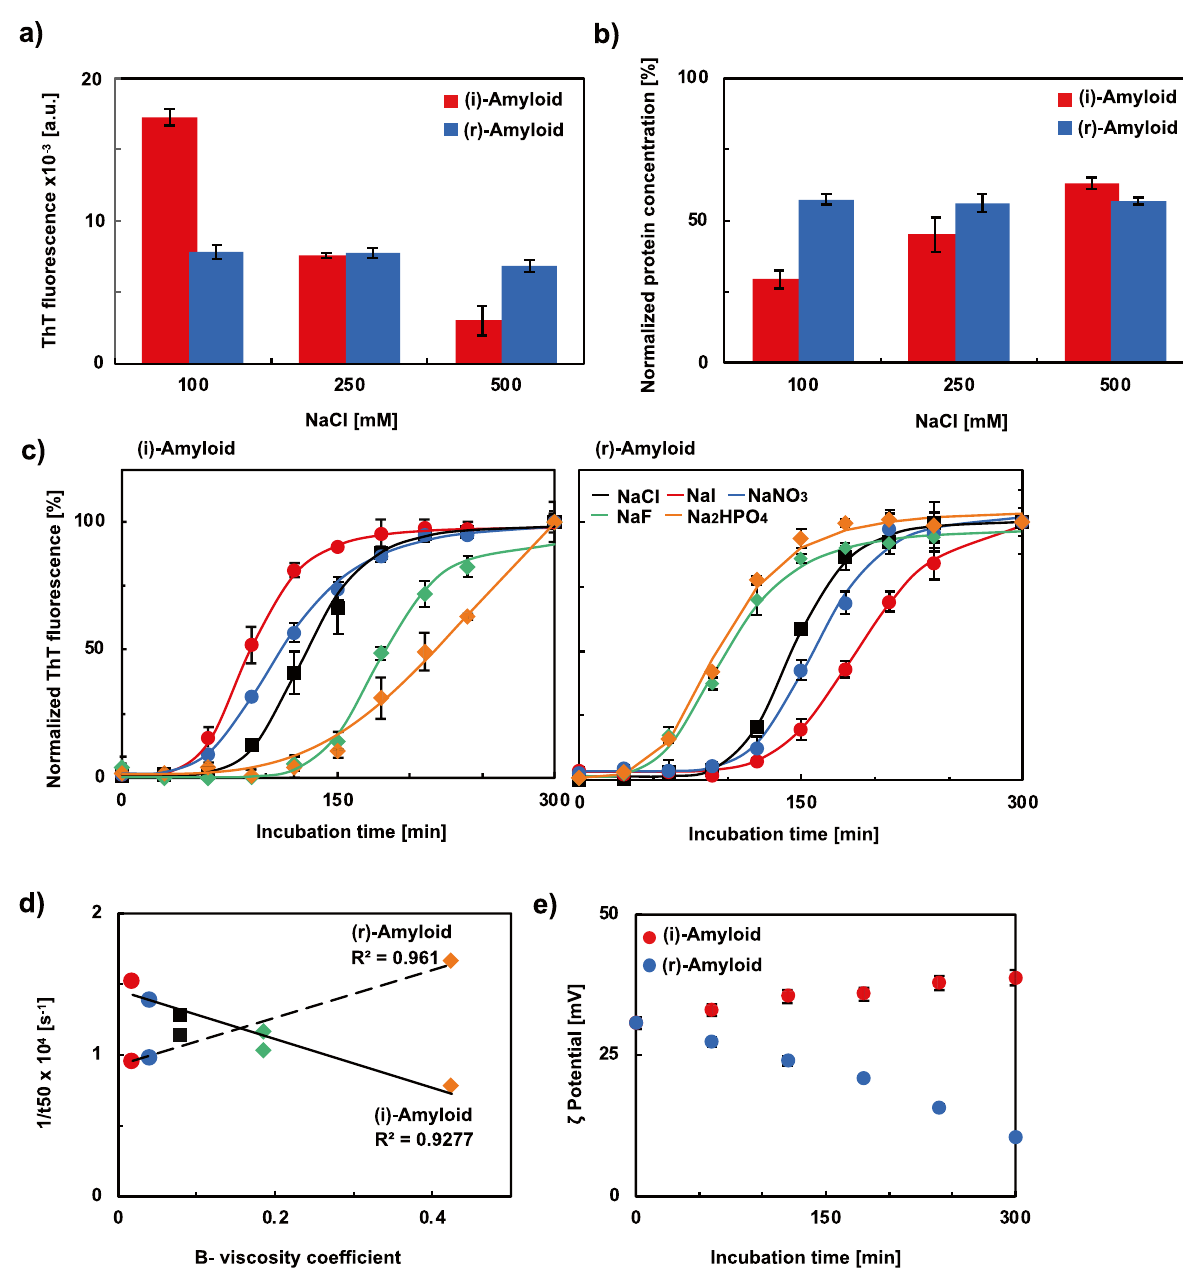
Figure 5. Evaluation of the effect of salts on the formation of insulin amyloids. ( a ) ThT assay to confirm the dependency of the NaCl concentration: (i)-amyloids (red) and (r)-amyloids (blue). Peak fluorescence values at 490 nm (ThT). Protein concentrations were adjusted to 5 µM. ( b ) BCA assay of supernatant samples to confirm the dependency of the NaCl concentration: (i)-amyloids (red) and (r)-amyloids (blue). Protein concentrations were normalized to 2 mg/mL. ( c ) ThT assay to confirm the effect of salts on the kinetics of insulin amyloid formation of (i)-amyloids (left) and (r)-amyloids (right) using the Hofmeister series of salts (100 mM, NaI, red; NaNO 3 , blue; NaCl, black; NaF, green; Na 2 HPO 4 , orange). Normalized peak fluorescence values at 490 nm (ThT) are shown. Protein concentrations were adjusted to 5 µM. ( d ) The rank order of the effects of different anions on the rate (1/t 50 ) of insulin amyloids formation at 100 mM added salt versus their order in the Jones– Dole B-coefficient of the Hofmeister series of salts (NaI, red; NaNO 3 , blue; NaCl, black; NaF, green; Na 2 HPO 4 , orange). The approximation straight lines for (i)-amyloid (solid line) and (r)-amyloid (dotted line) are shown. ( e ) ζ potential measurement to confirm the time dependency of the charge: (i)-amyloids (red) and (r)-amyloids (blue). These samples were incubated for the indicated periods. The protein concentration in the precipitate was adjusted 86 µM (0.5 mg/mL). The average values of three repeated measurements are